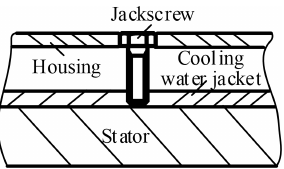
Figure 16. Schematic diagram of the motor spindle jacking wire.